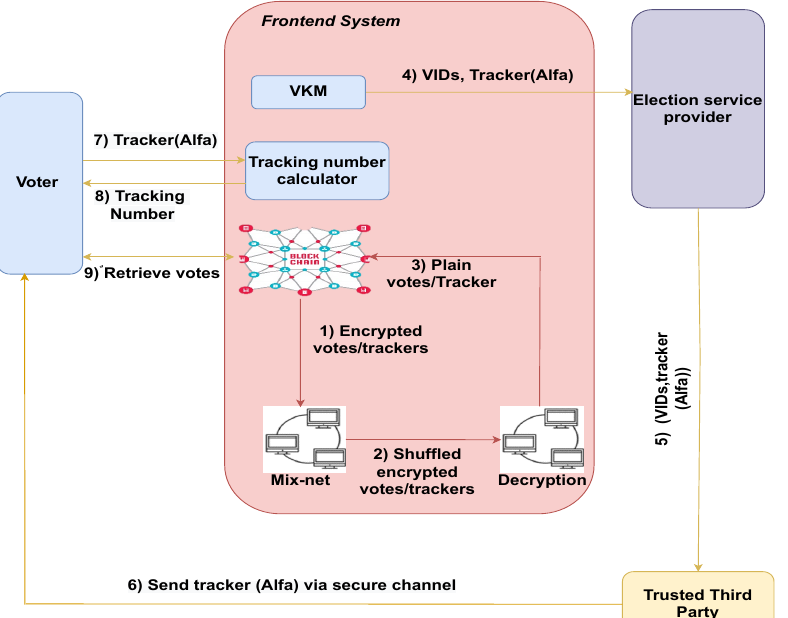
Figure 6. Voter experience during the post-election phase and tracking-number retrieval